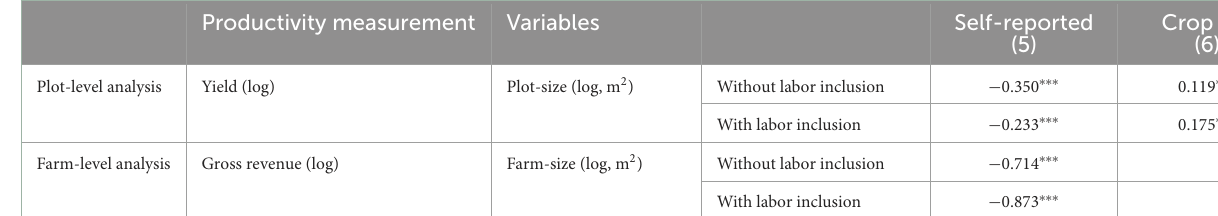
TABLE 3 Whole sample regression summary